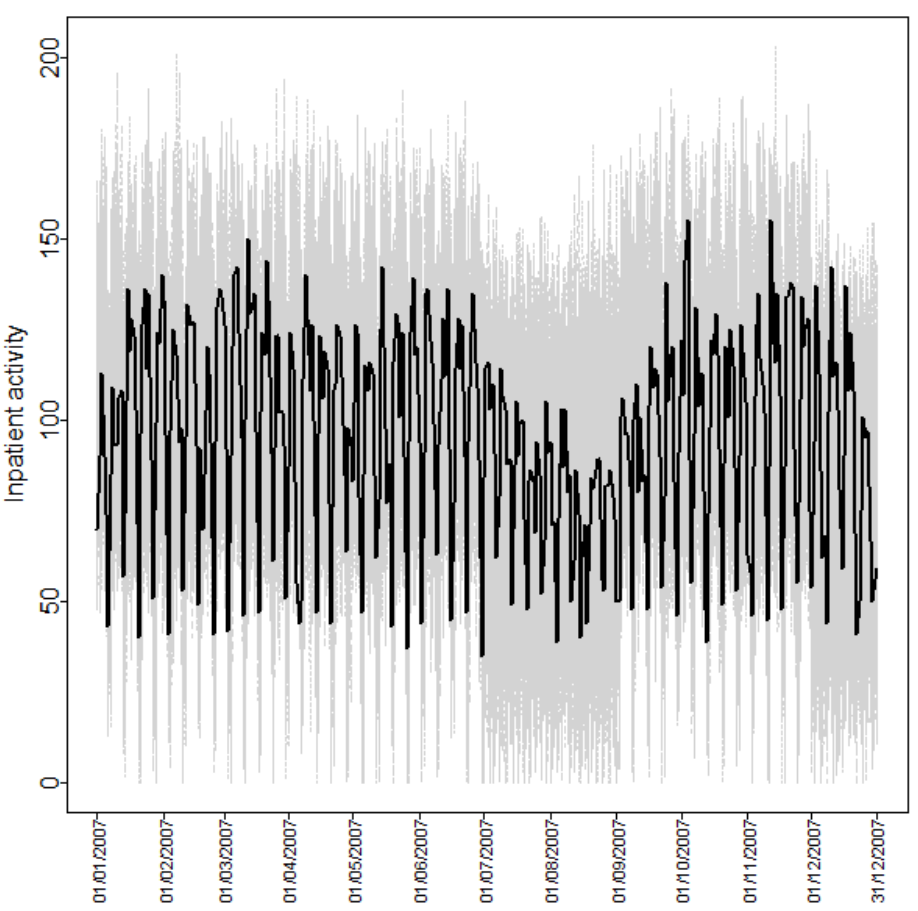
Figure 3. Actual inpatient activity (solid black line) and simulated inpatient activity (grey lines) in